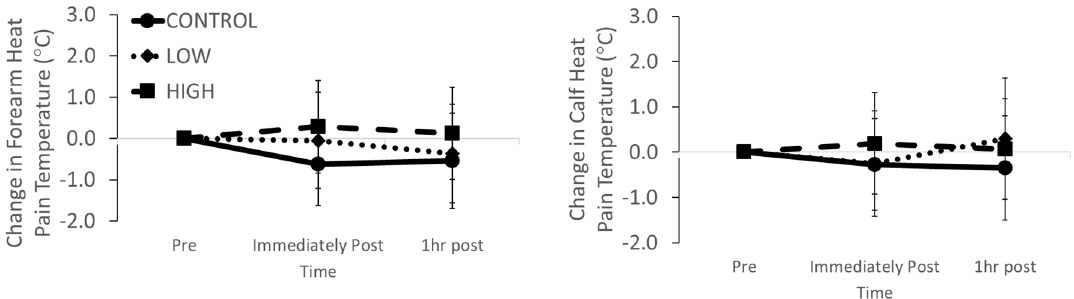
Figure 2. Changes in forearm and calf skin heat pain thresholds immediately and 1 hr after LOW and HIGH exercise and CONTROL.